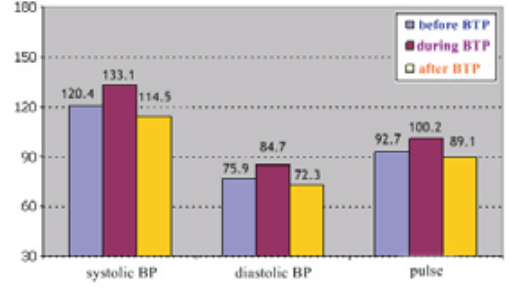
FIGURE 1. Number of BTP through days of treatment in all examinees